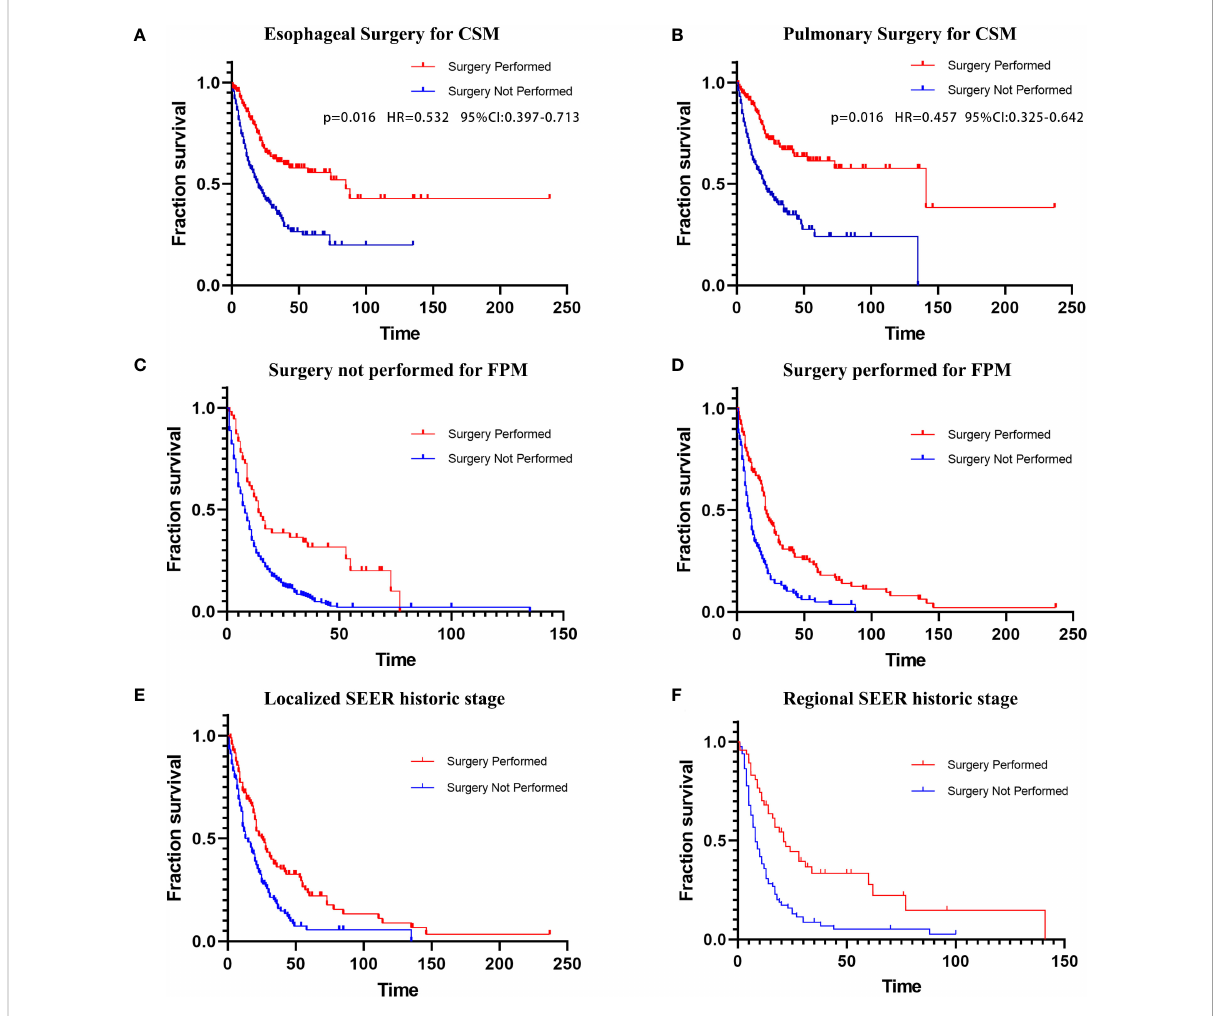
FIGURE 3 (A) Esophageal CSM in patients undergoing esophageal surgery; (B) Lung CSM in patients undergoing pulmonary surgery. Kaplan – Meier curves of overall survival in patients undergoing surgery for SPM; (C) Surgery not performed for FPM; (D) Surgery performed for FPM; (E) Localized SEER historic stage; (F) Regional SEER historic stage. CSM, cancer-speci fi c mortality; FPM, fi rst primary malignancy; SPM, second primary malignancy; SEER, Surveillance, Epidemiology, and End